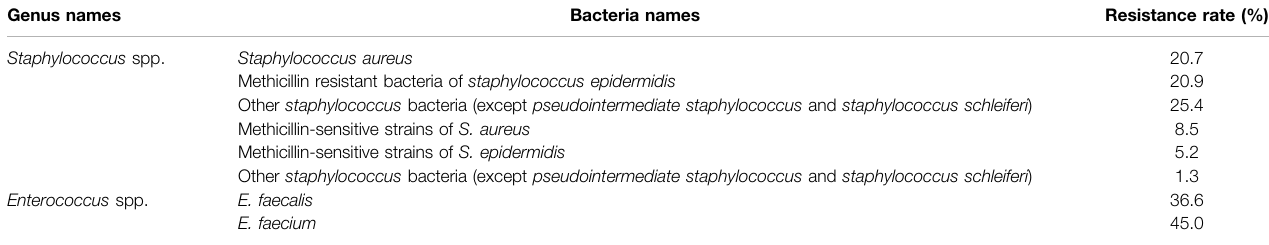
TABLE 1 | Resistance rates of common gram-positive cocci to gentamicin.